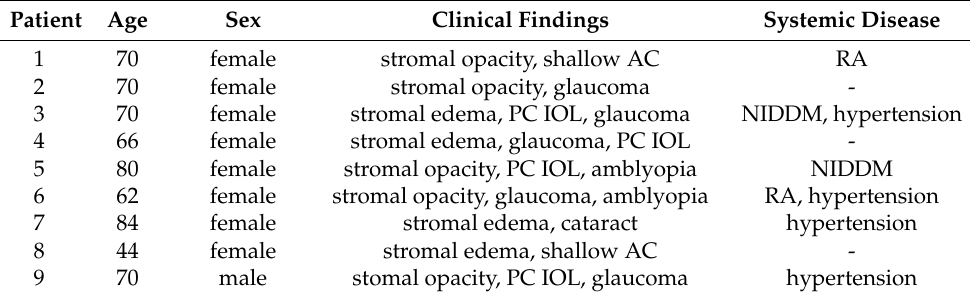
Table 2. Clinical characteristics of FECD